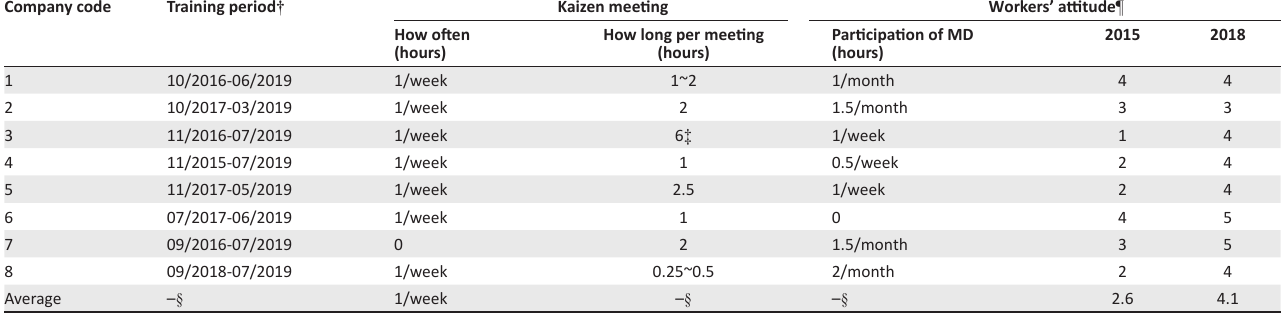
TABLE 3: Kaizen meeting and change in the workers’ attitude between before (2015) and after (2018) Kaizen training. Company code